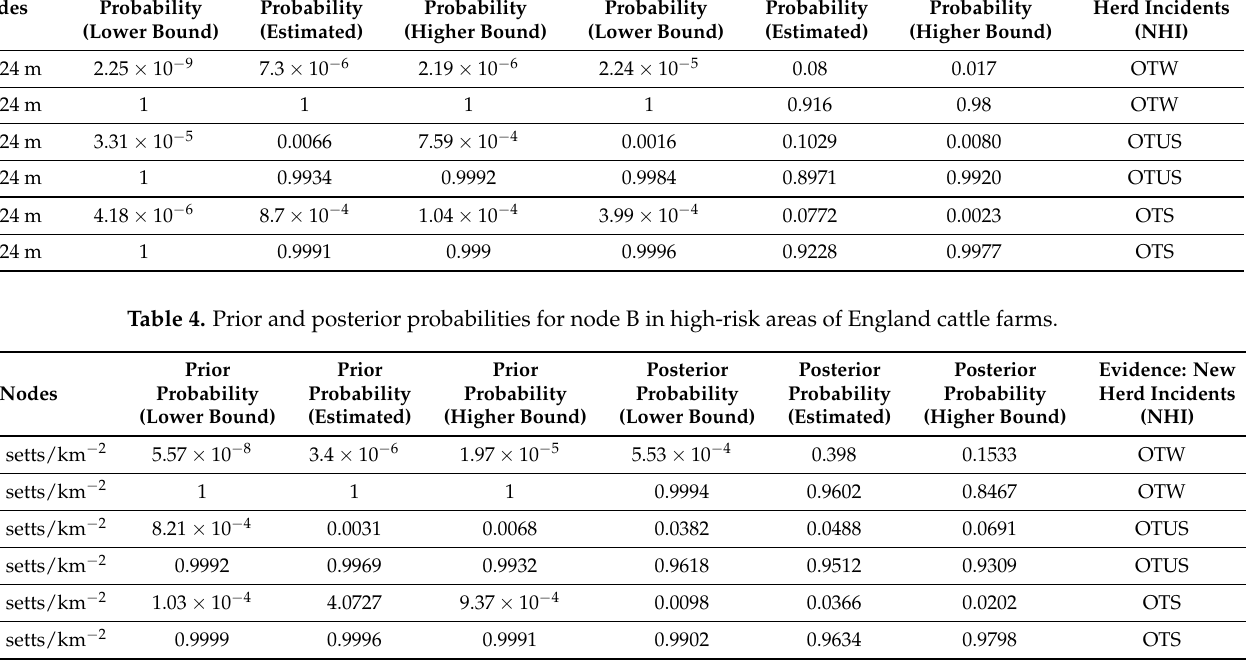
Table 3. Prior and posterior probabilities for node A in high-risk areas of England cattle farms. Prior Probability Nodes